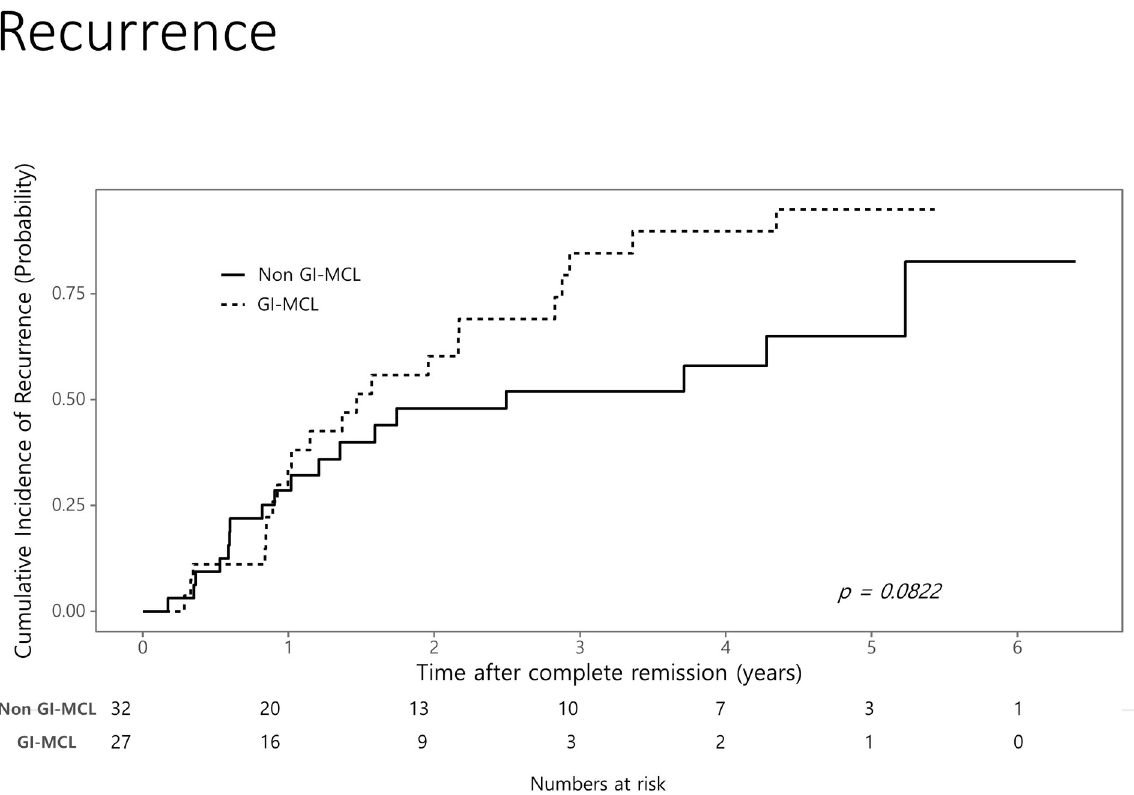
Fig 2. Cumulative incidence of recurrence following complete remission in patients with mantle cell lymphoma according to gastrointestinal involvement. Cumulative incidences of recurrence in the GI-MCL and non GI-MCL groups at 3 years were 94.8% and 64.9%, respectively.